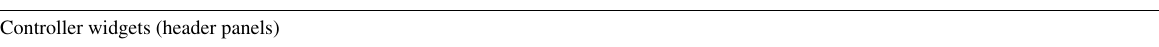
Legend Placeholder widgets (on-screen panel)